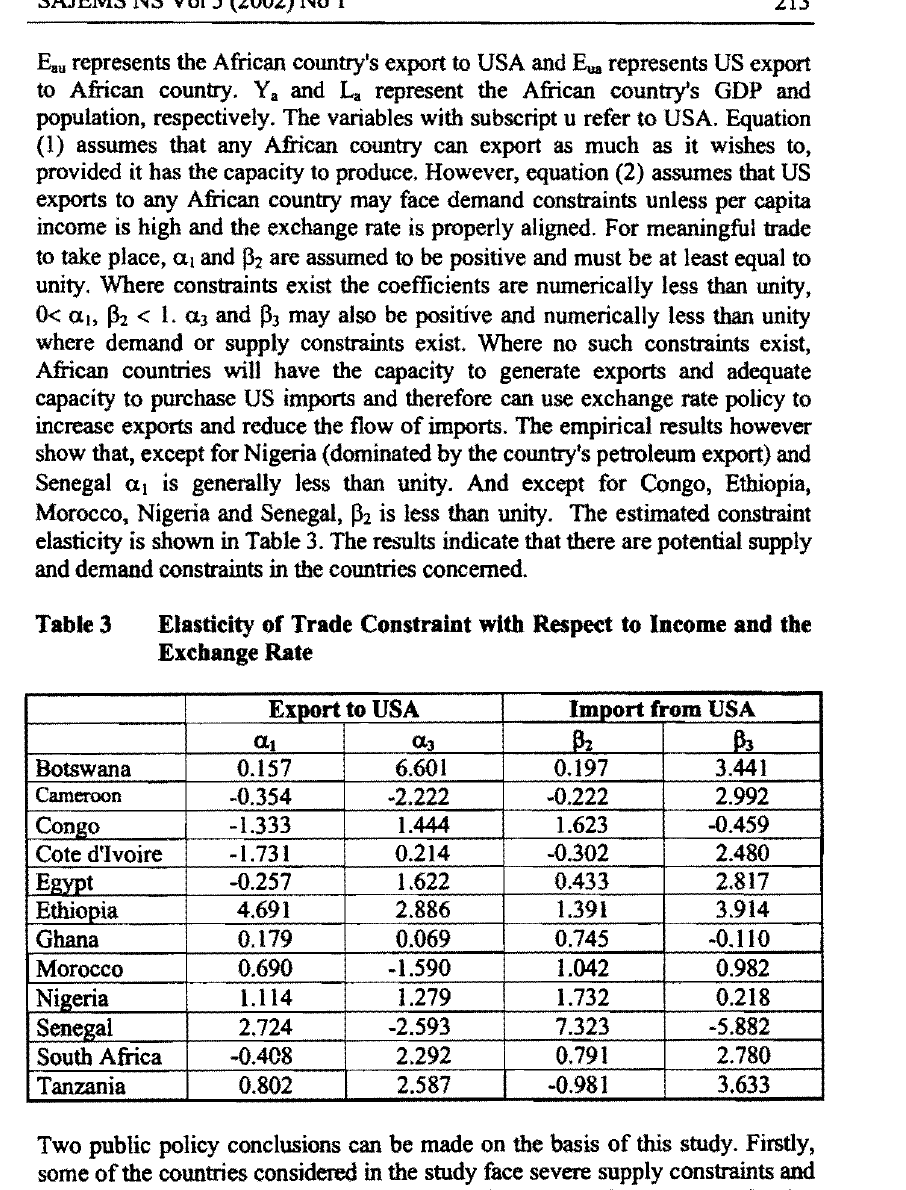
Elasticity of Trade Constraint with Respect to Income and the Excbange Rate Export to